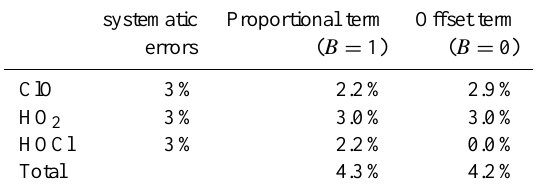
Table A1. Impacts of the systematic errors.